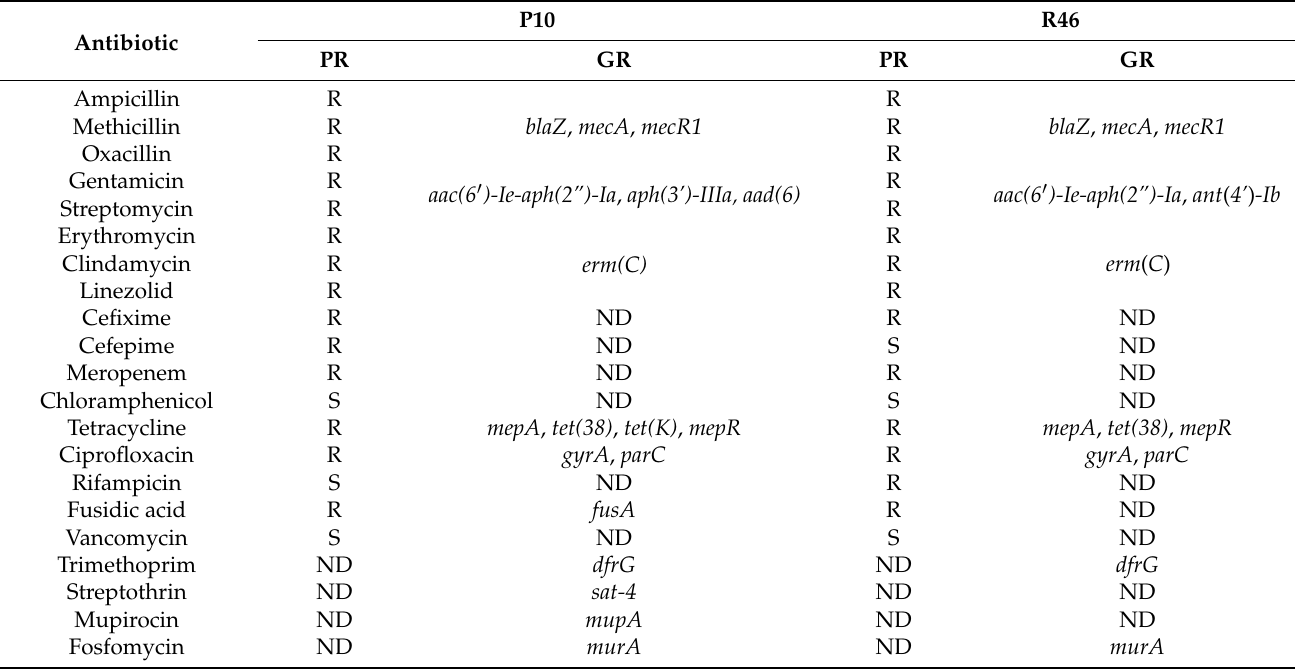
Table 1. Phenotypic and genotypic antibiotic resistance profile of MRSA strains P10 and R46. Antibiotic